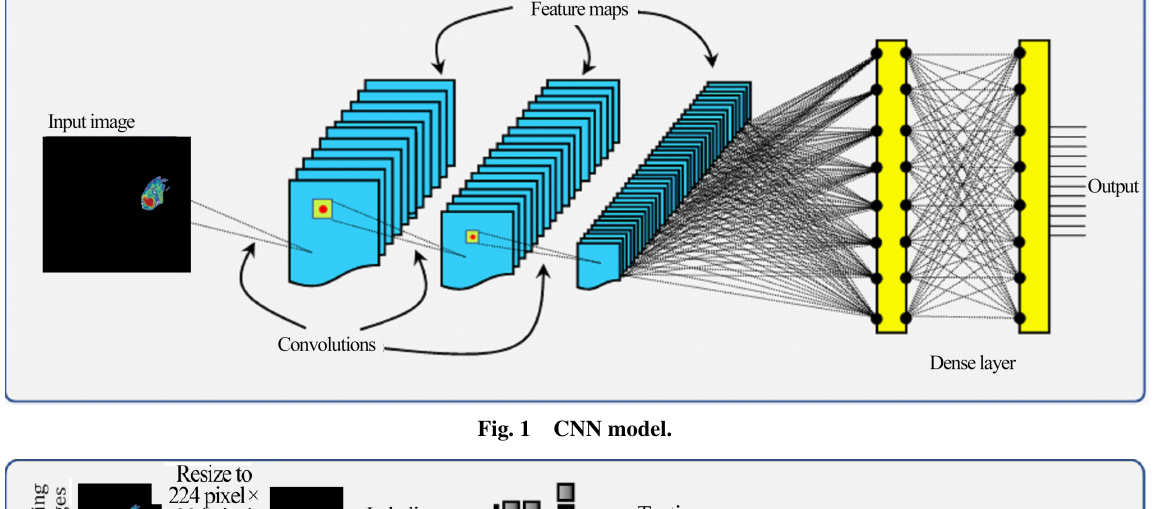
Fig. 1 CNN model.